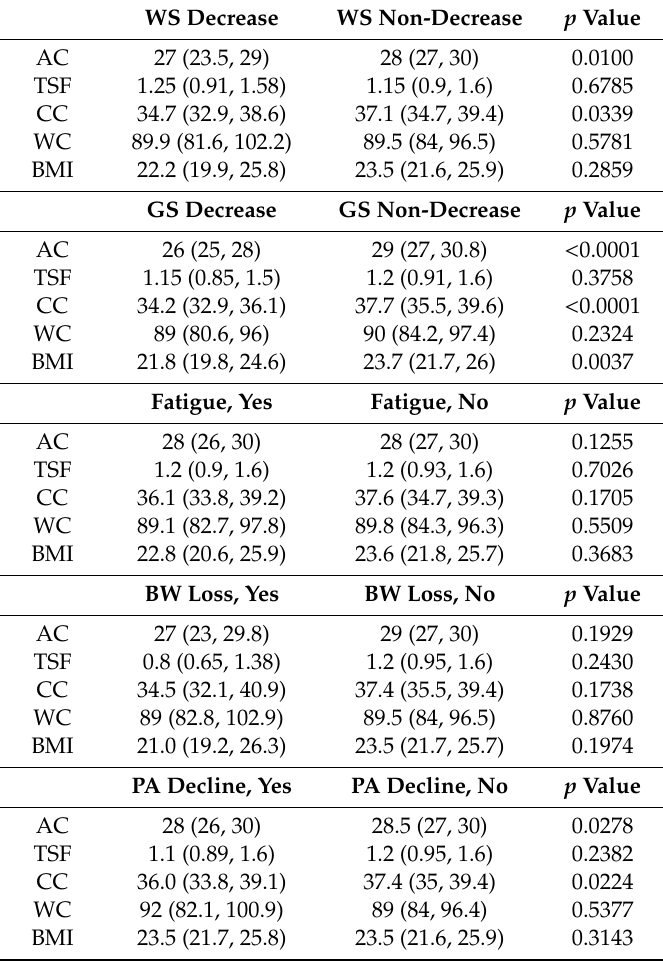
Table 2. Anthropometric measurements according to the frailty phenotypes in male